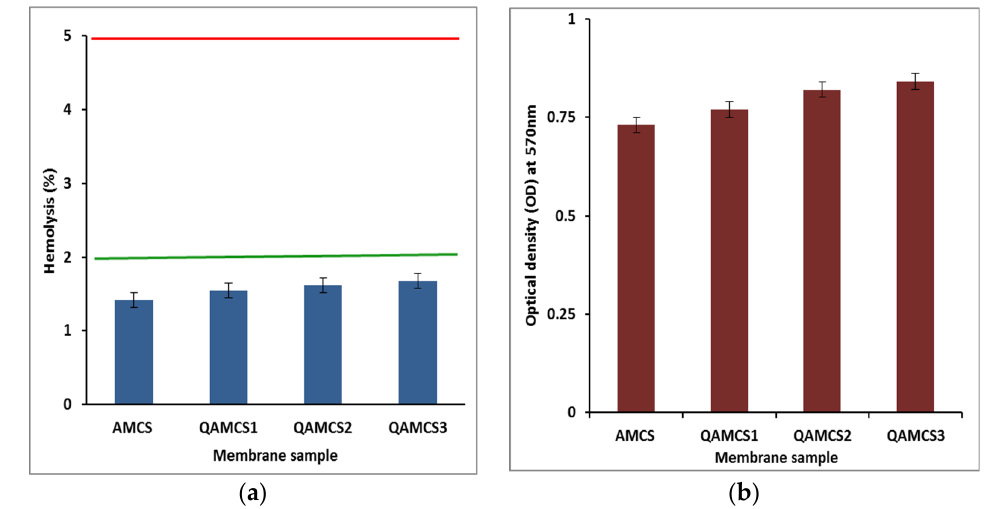
Figure 5. ( a ) Hemocompatibility data and ( b ) biodegradation profiles of aminochitosan, quaternized aminochitosan 1, quaternized aminochitosan 2 and quaternized aminochitosan 3 membranes. All measurements were accomplished in triplicate ( n = 3), and data obtained are expressed as means and standard deviations